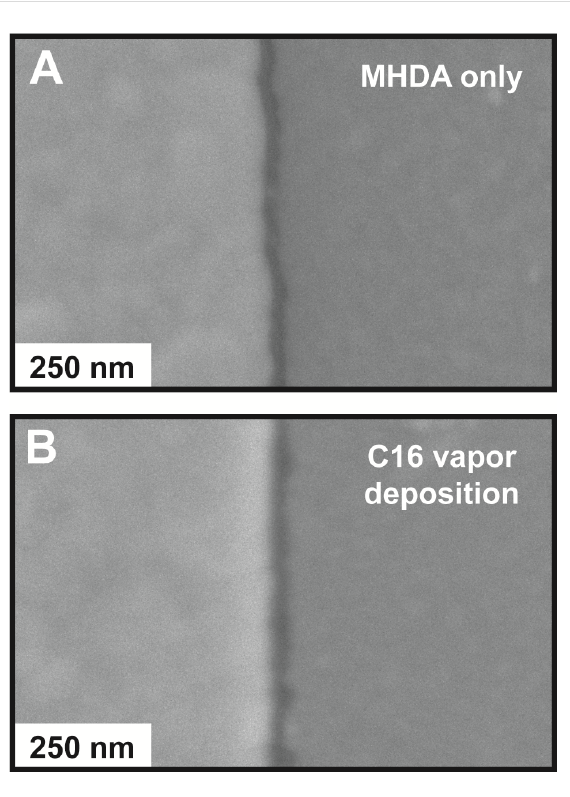
Figure 4: Nanogaps from MHDA only and MHDA with vapor-phase deposition of C16. (A) A representative SEM image of a nanogap fabri- cated from nine iterations of the solution deposition of MHDA and